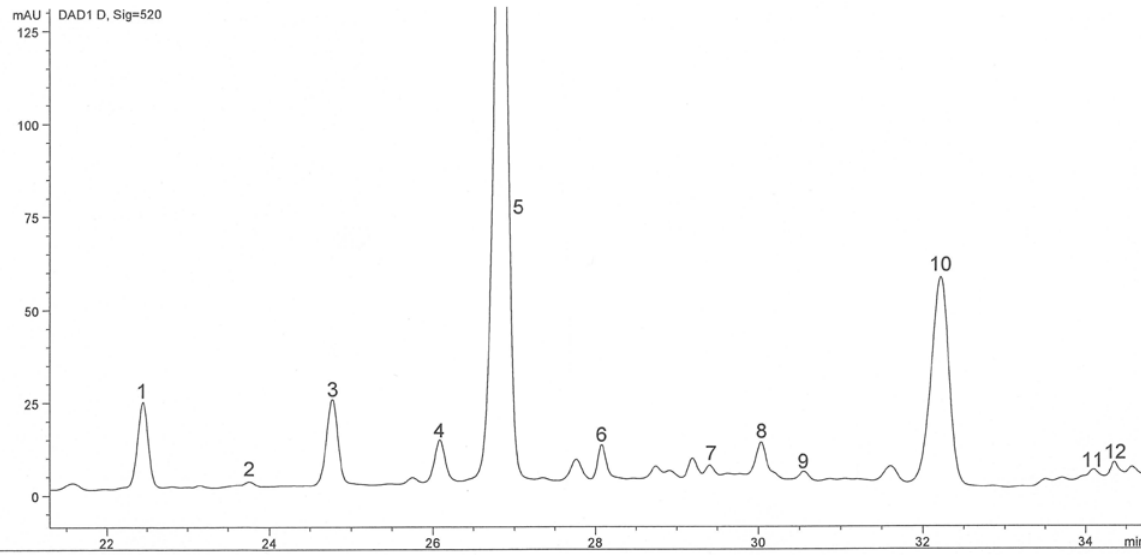
Figure 1. HPLC chromatogram of anthocyanins in Cabernet Sauvignon wine from Oplenac viticulture region (Serbia) monitored at 520 nm.